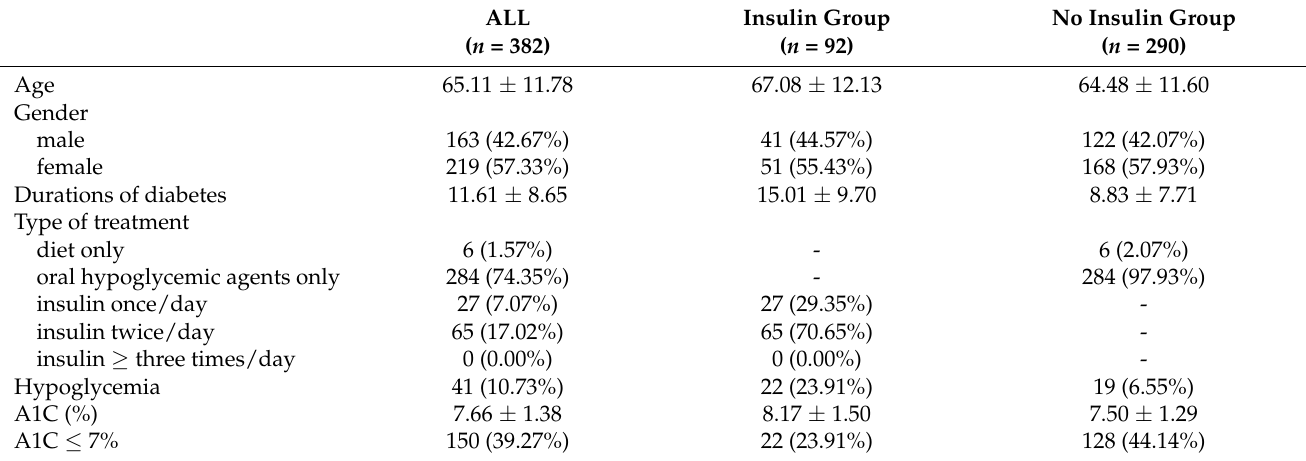
Table 1. Clinical characteristics and laboratory data stratified by insulin treatment and no insulin